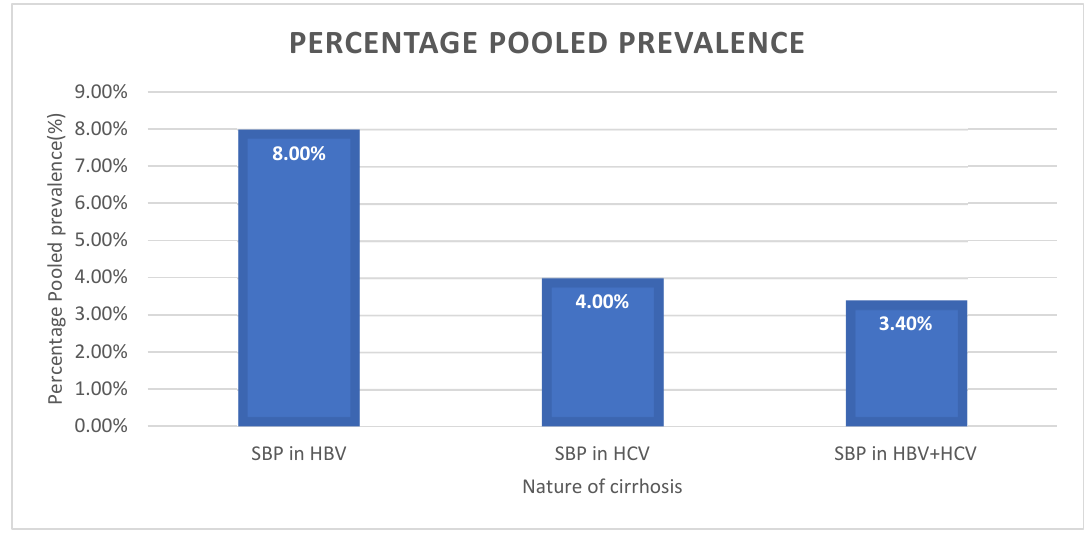
Figure 2. A bar chart showing the pooled prevalence of SBP in HBV and HCV cirrhosis. The pooled prevalence of SBP in HBV liver cirrhosis had the highest estimate [8.0% (95%CI: 2.7–21.0%, I 2 = 96.13%, p ≤ 0.001)] (Figures 3 and 4), followed by SBP in HCV associated liver cirrhosis, with an estimate of 4.0% (95%CI: 1.3–11.5%, I 2 = 88.99%, p ≤ 0.001) (Figure 5). The pooled estimate of SBP in liver cirrhosis caused by both combination of HBV and HCV had the lowest prevalence in the category of SBP in viral cirrhosis [3.4%